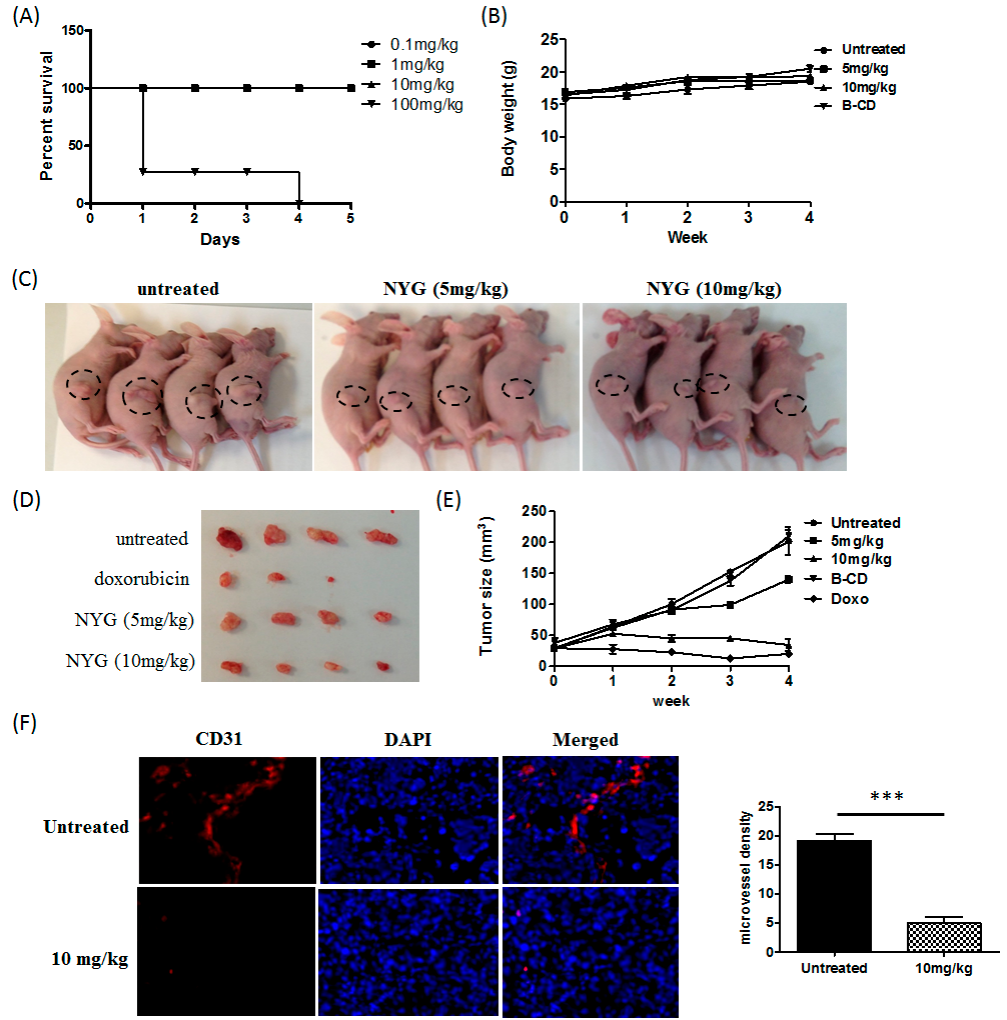
Figure 1. NYG suppressed xenograft growth of HCC in vivo. ( A ) Mice were treated with 0.1, 1, 10 and 100 mg/kg of NYG (i.p.) on five consecutive days ( n = 5); ( B , C ) Subcutaneous xenograft mice were treated with NYG, either 5 mg/kg or 10 mg/kg, via i.p. injection. The body weight was monitored and measured as average of replicates ( n = 5) with standard deviation; ( D ) The tumors were excised and measured as average ± SD (mm 3 ). The tumor size of NYG (10 mg/kg) treatment group is smaller than the saline-given mice group; The subcutaneous tumor growth is indicated by circle; ( E ) The tumor size was monitored and measured every week after subcutaneous injection of tumor cells; ( F ) Histological sections of excised hepatocellular carcinoma (HCC) tumor staining with cluster of differentiation 31 (CD31) antibody in control and NYG-treated mice (10 mg/kg). The vascular density of each section was measured as the mean number of microvessel in five histological areas (100× magnification); NYG intervention significantly reduced CD31-stained microvessel density in xenograft mice. *** p < 0.001.